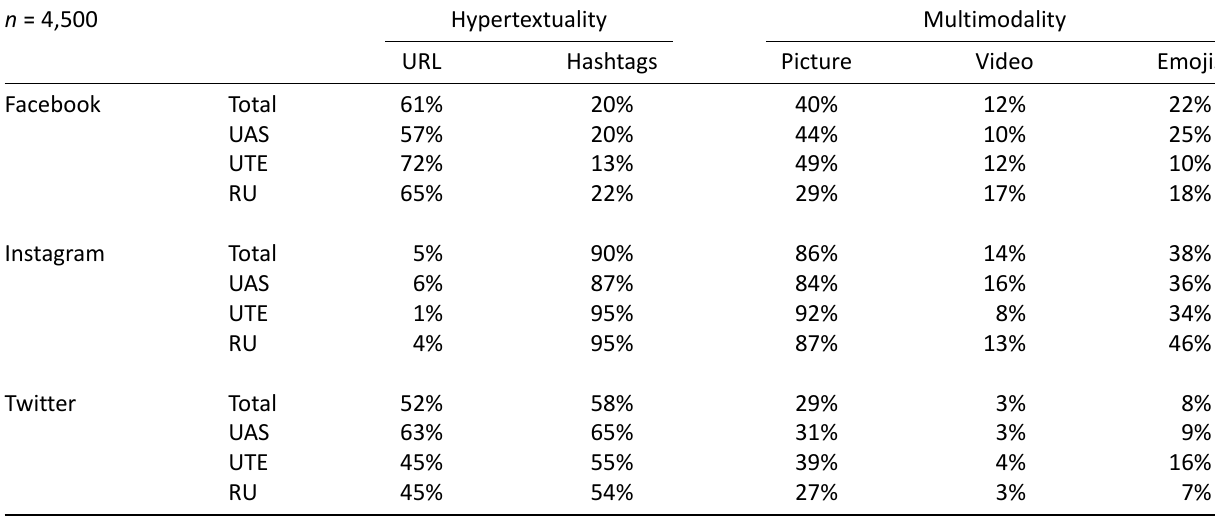
Table 1. Hypertextual and multimodal features per platform and HEI. n =